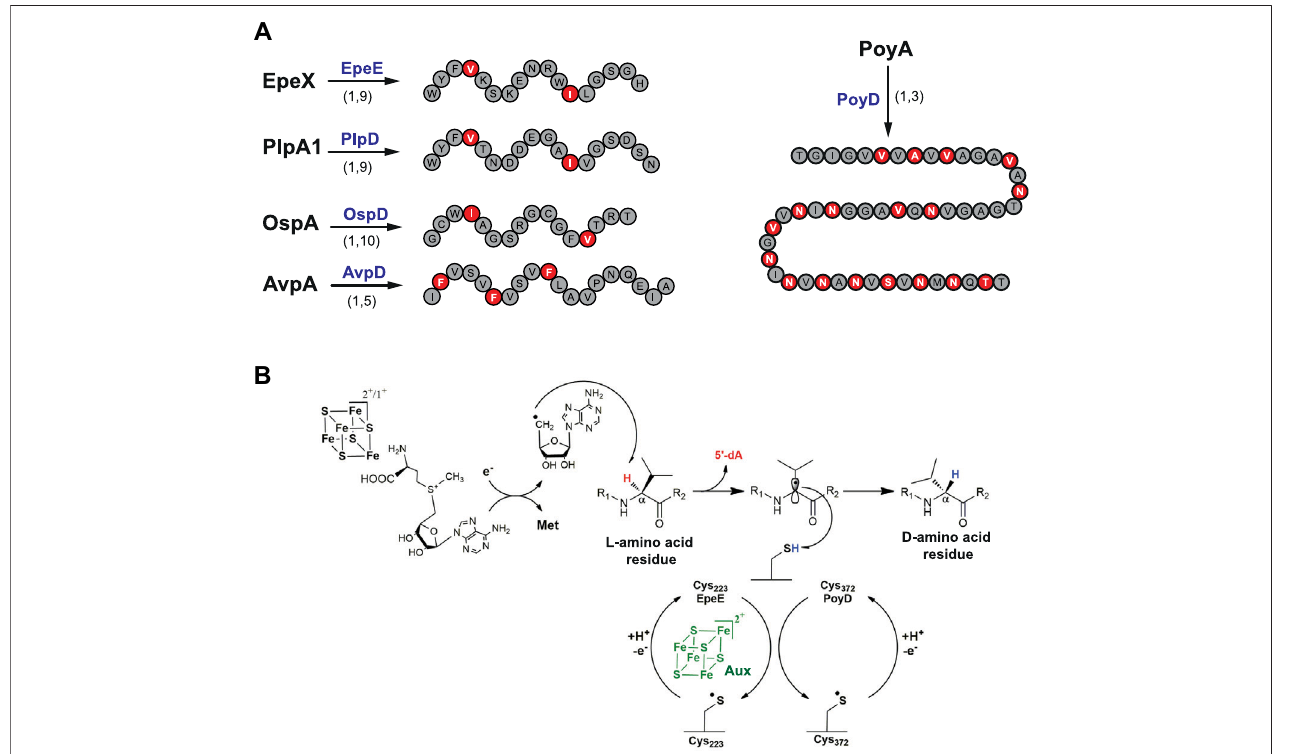
FIGURE 6 | Epipeptides and proteusins. (A) Epimerization pattern of proteusins and epipeptide. Above the arrows, names of the radical SAM enzymes catalyzing epimerization reactions. Below the arrows, the numbers indicate the epimerization patterns. (B) Proposed mechanism for epimerization catalyzed by radical SAM